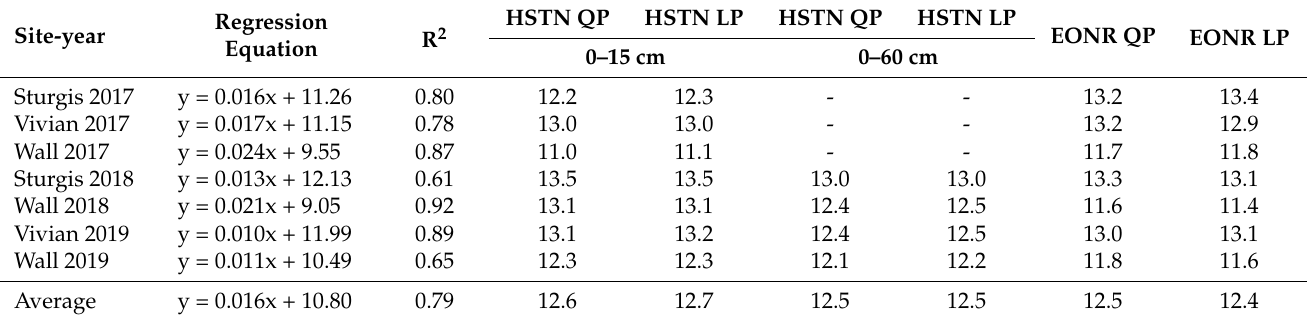
Table 6. Estimated parameterized percent protein values based on the regression of applied fertilizer N on protein content for each